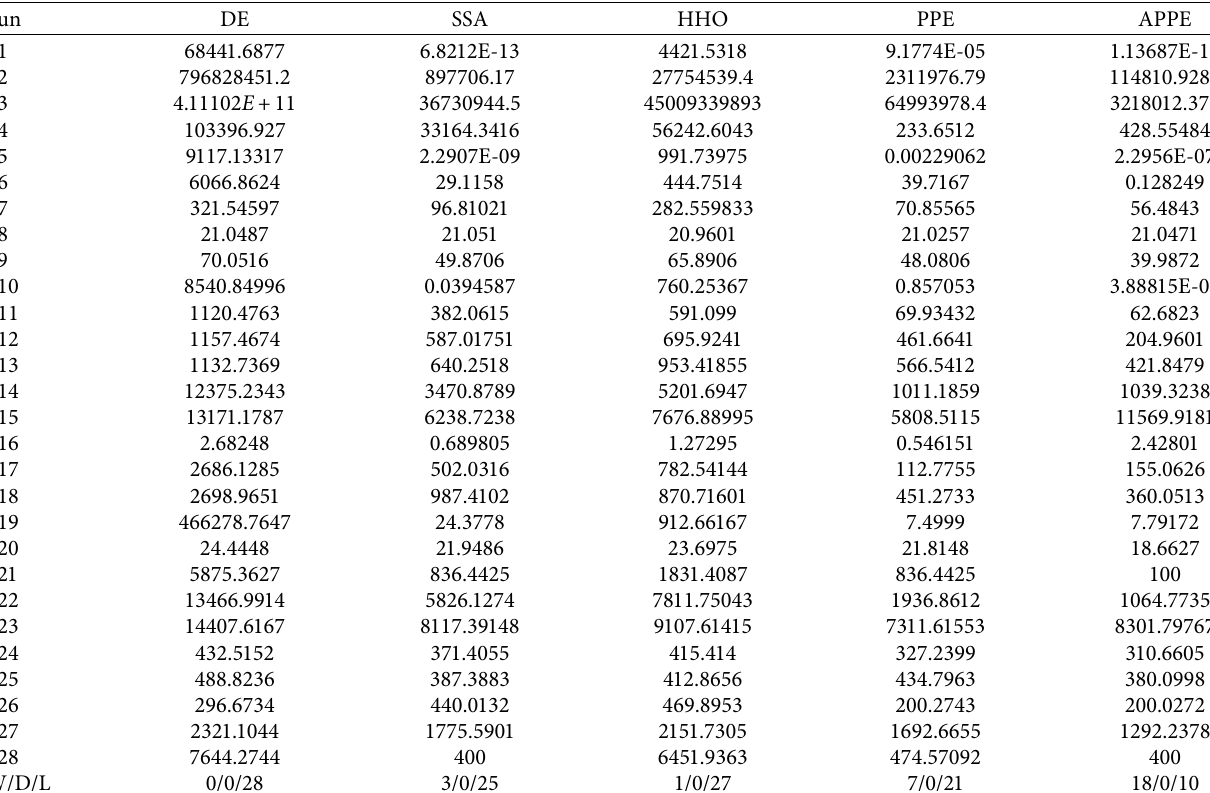
Table 10: Comparison of the best result of 51 runs on 50D in 28 benchmark functions.